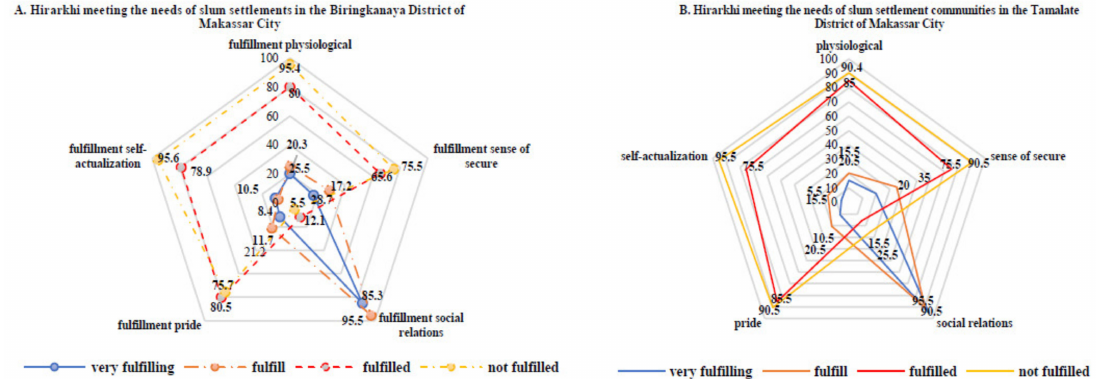
Figure 11. Fulfilling community needs in slums in Makassar suburbs: ( A ) Biringkanaya district; ( B ) Tamalate district. Source: Primary Data,